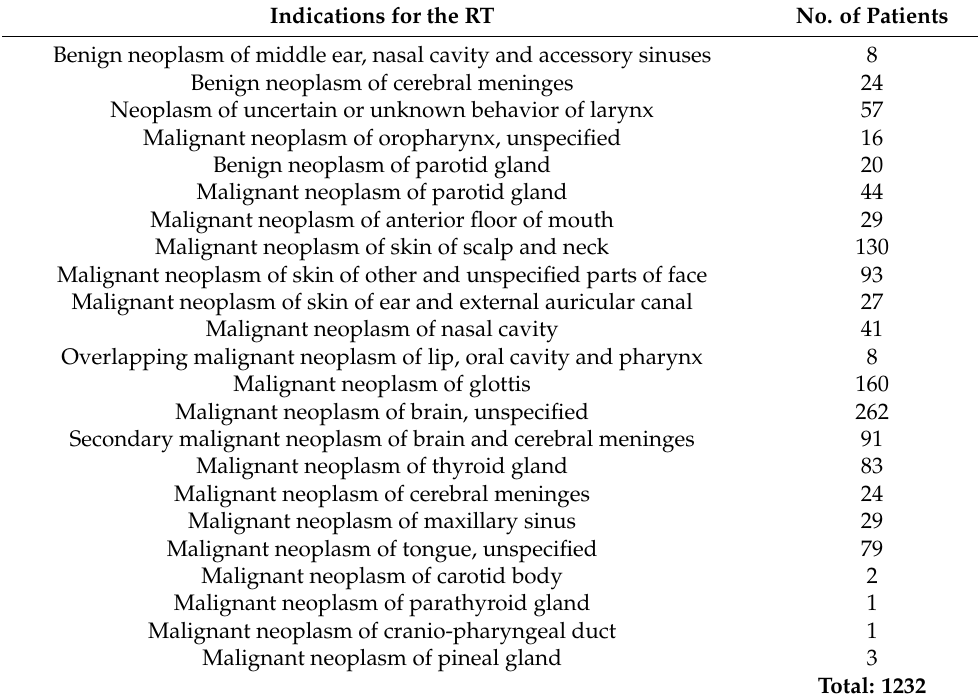
Table 1. Indications for the RT. Indications for the RT No. of